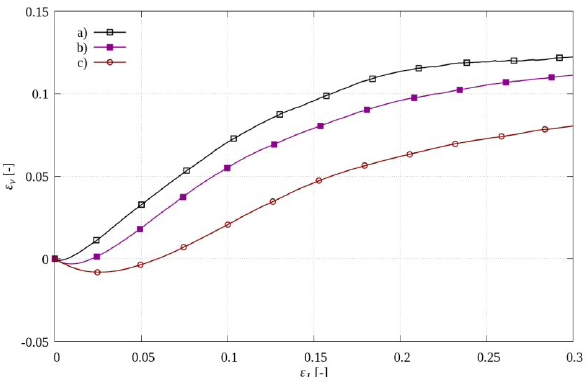
versus vertical normal strain ε from v 1 = 50 kPa, b) σ = 200 kPa 0 0